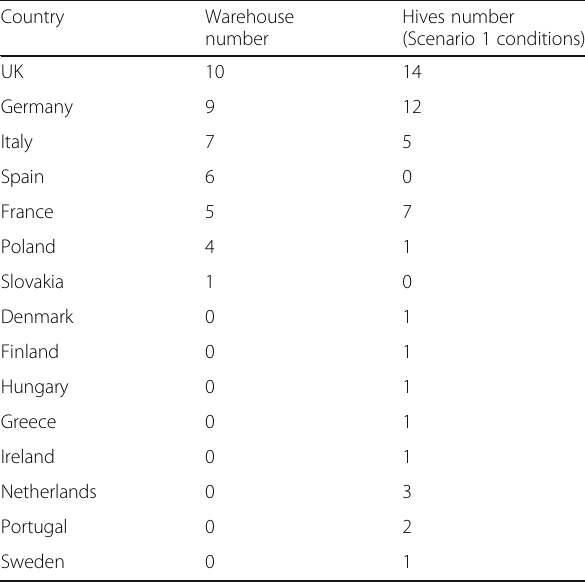
Table 2 Comparison of modeled hive numbers and existing Amazon warehouses (data from